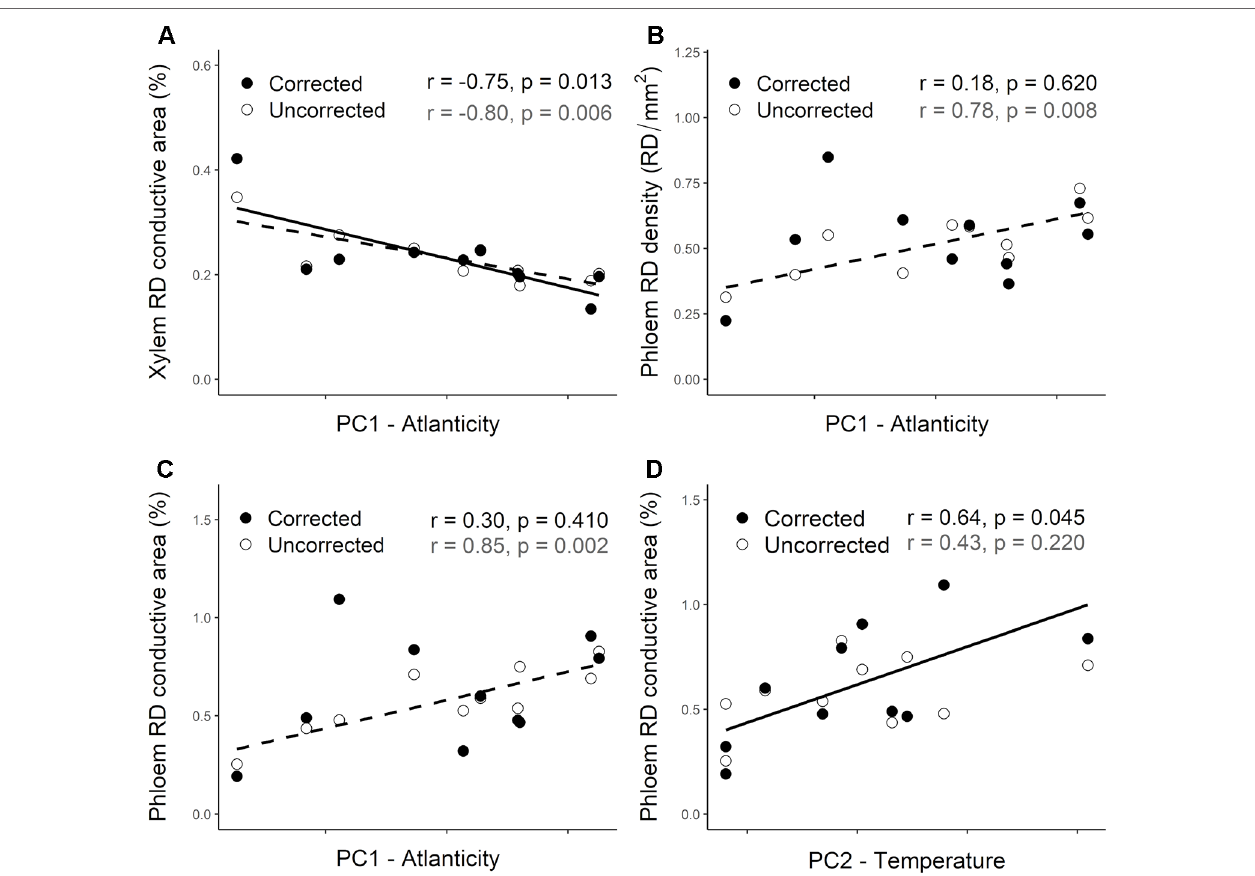
FIGURE 6 | Relationship between climate indices (PC1 and PC2) and the constitutive resin duct characteristics — Resin duct density (RD density, RD/mm 2 , panel B ) and/or conductive area (RD conductive area, %, panels A , C and D ) — in the xylem (A) and phloem (B , C , D) across 10 Pinus pinaster populations. White circles represent uncorrected population least squared means, whereas dark circles represent corrected data after accounting for the population genetic structure in the corresponding mixed models. Higher values of PC1 are indicative of Atlantic climates with higher precipitation and lower thermic oscillation, whereas lower values are associated with Mediterranean climates. PC2 is positively associated with temperature and potential evapotranspiration. Pearson correlation coef fi cients (r) and associated p-values (p) are shown for uncorrected (gray) and corrected (black) data. Signi fi cant correlations are also represented with trend lines (dashed — uncorrected; solid —